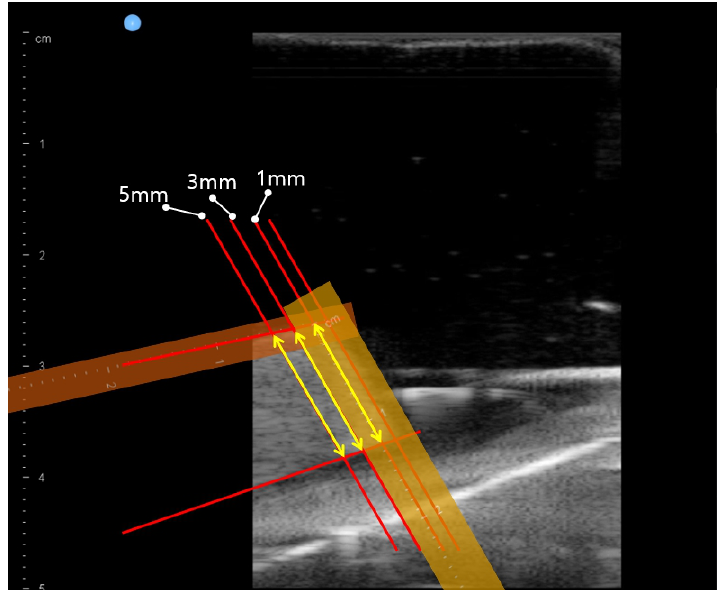
Figure 11. Thickness measurement positions at θ = − 40 ◦ (yellow arrows represent thickness 1, 3 and 5 mm from the upper right corner of the bean curd as depicted in Figure